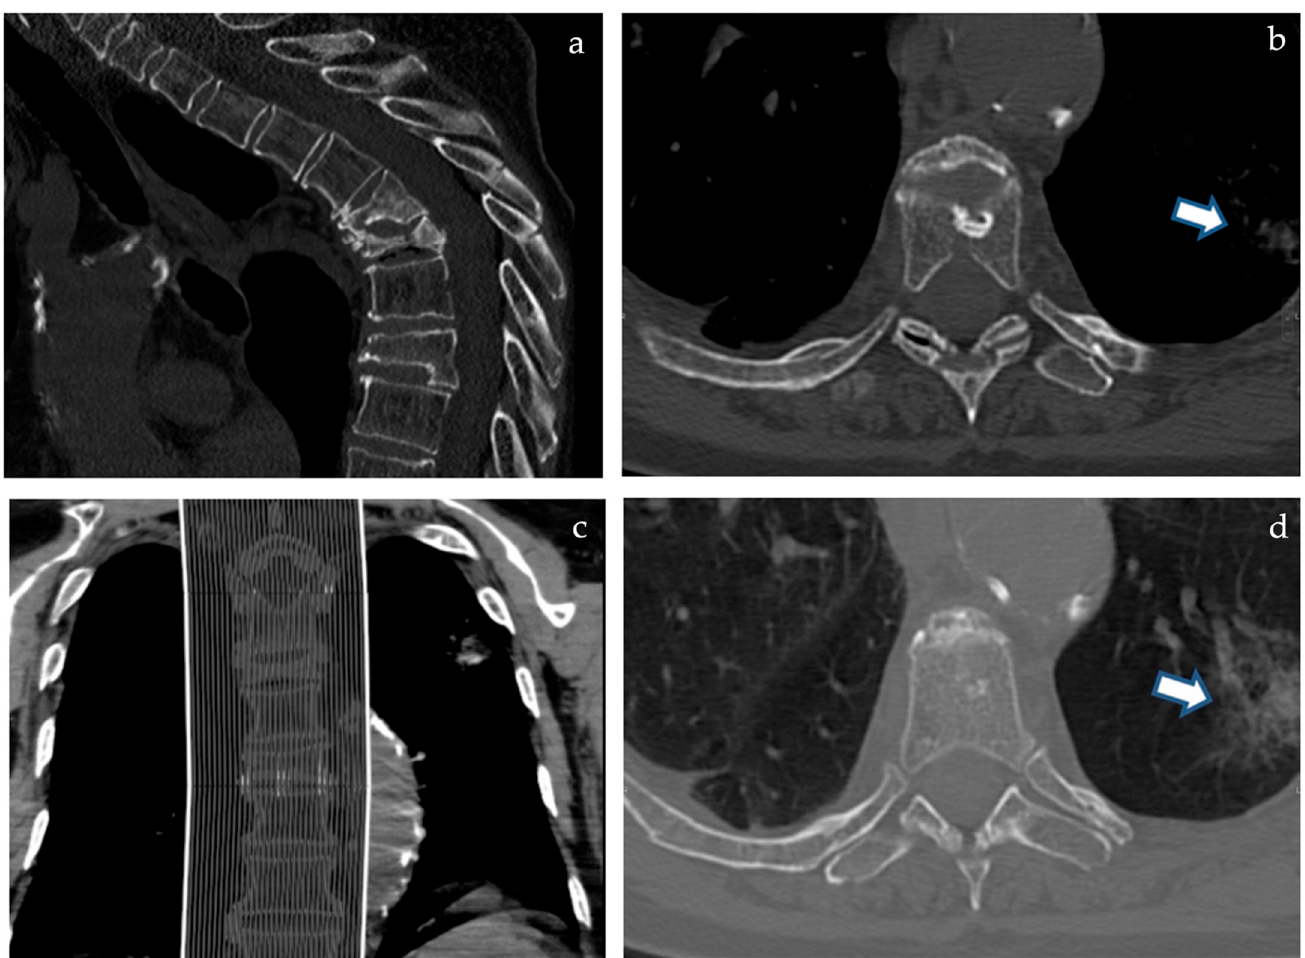
Figure 1. ( a ) ( above left ), ( b ) ( above right ) , ( c ) ( below left ), and ( d ) ( below right ). A 77-year-old female patient with unbearable pain due to T5 and T6 spontaneous severe fractures ( a , c ) performed CT among a different institution due to the scarce compliance required for Magnetic Resonance. While reviewing CT imaging in our Interventional Radiology consultation office to assess the indication for vertebroplasty, a left lung opacity was noticed on “bone window” ( b , arrow) and was confirmed and more evident when switching to “lung window” view mode ( d , arrow).